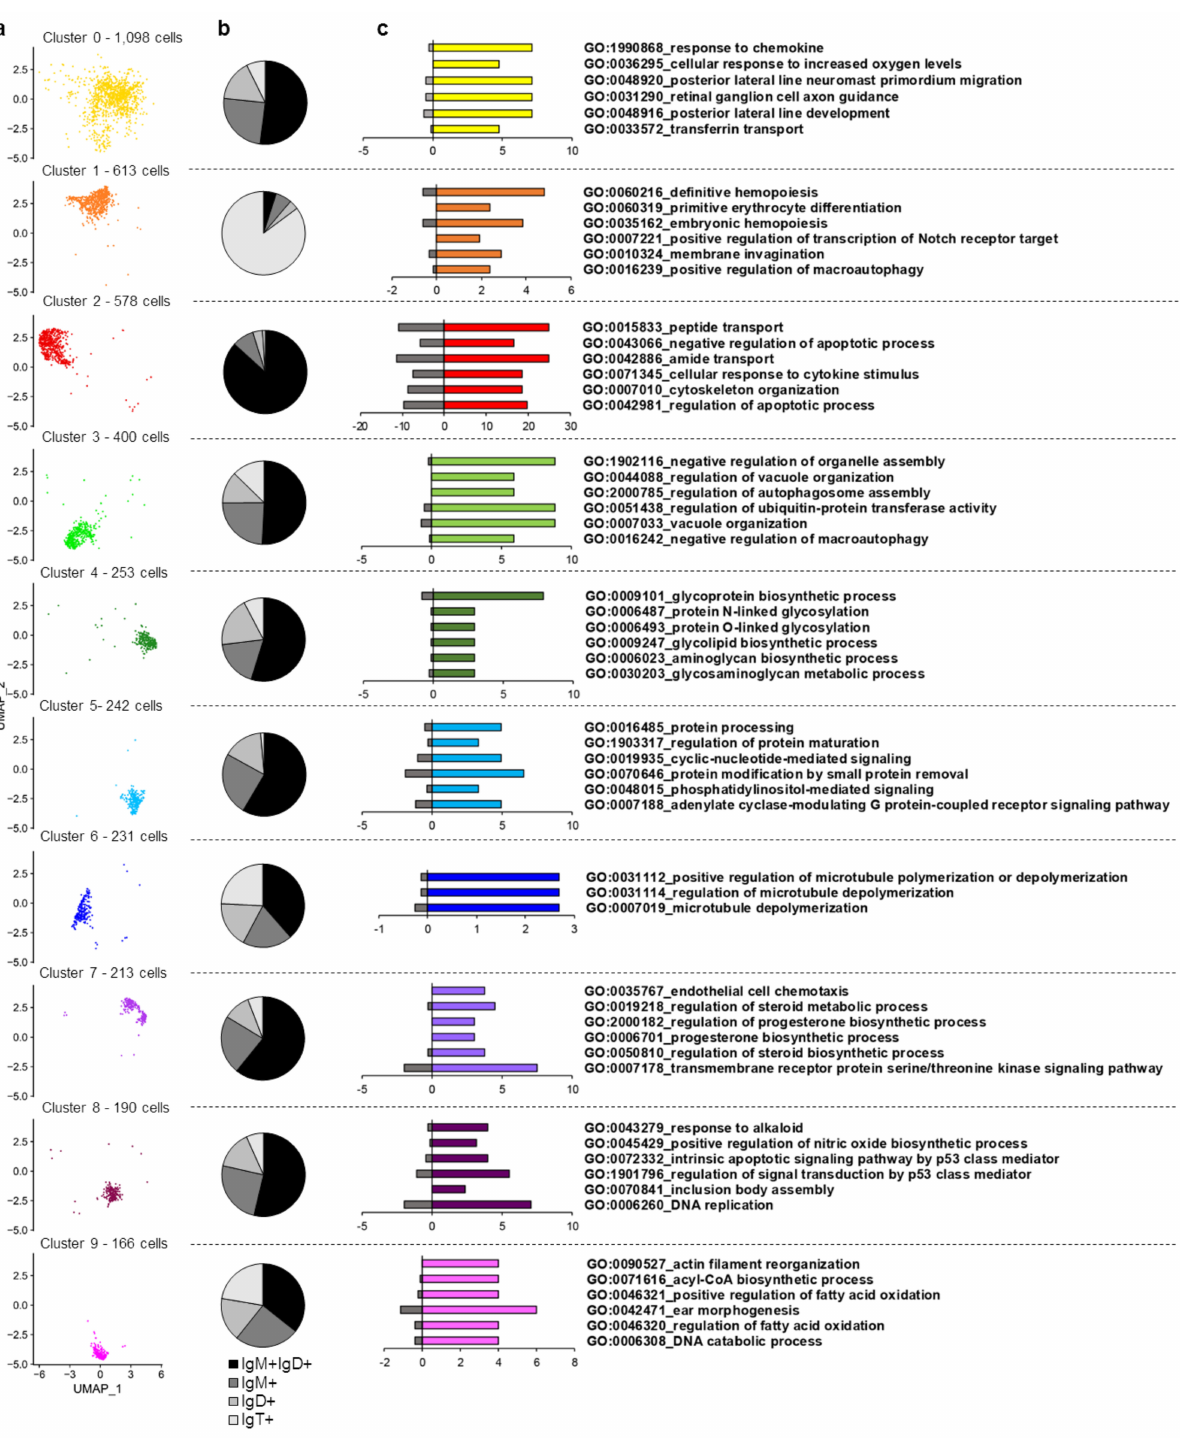
Figure 3. Cluster definition including immunoglobulin profile of cells and functional analysis of marker transcripts. ( a ) UMAP visualization of cells in each cluster. ( b ) Percentage of cells within each cluster assigned to common heavy chain Ig subsets (IgM + IgD + , IgM + , IgD + and IgT + ) according to their transcriptional analysis. ( c ) Single enrichment analysis along the different cell clusters. Graphs show the percentage of genes within the most significant GO terms at level six within the biological process category for each specific cluster (colored bars) versus the percentage of genes from this category found in the rest of clusters (grey